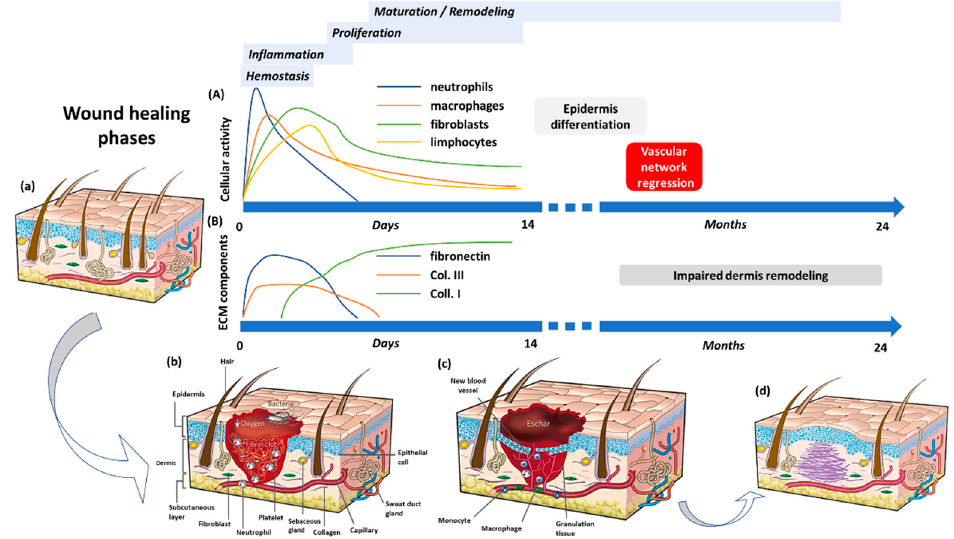
Figure 1. Schematic representation of wound healing phases: ( A , B ) Temporal evolution of cell- mediated wound healing and relative ECM components synthesis, ( a ) Undamaged skin, ( b ) Hemostatic phase and immune cells invasion in the wound bed, ( c ) Proliferation phase characterized by keratinocytes, fibroblasts and endothelial cells migration and proliferation for angiogenesis, collagen deposition, granulation tissue formation, re-epithelialization, and wound contraction to occur, ( d ) Maturation phase consisting in collagen remodeling (from type III to type I) and wound closure. Reprinted from Gurtner GC, Werner S, Barrandon Y et al. Wound repair and regeneration. Nature 2008; 453:314–21 [16] with permission from Springer Nature.